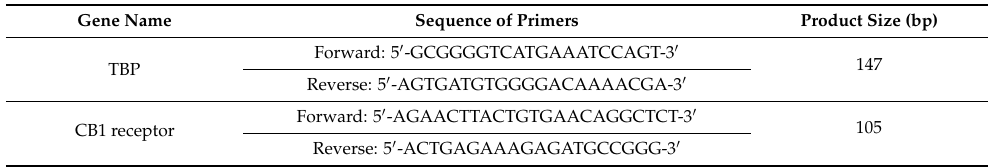
Table 1. Sequence of the primers of the research